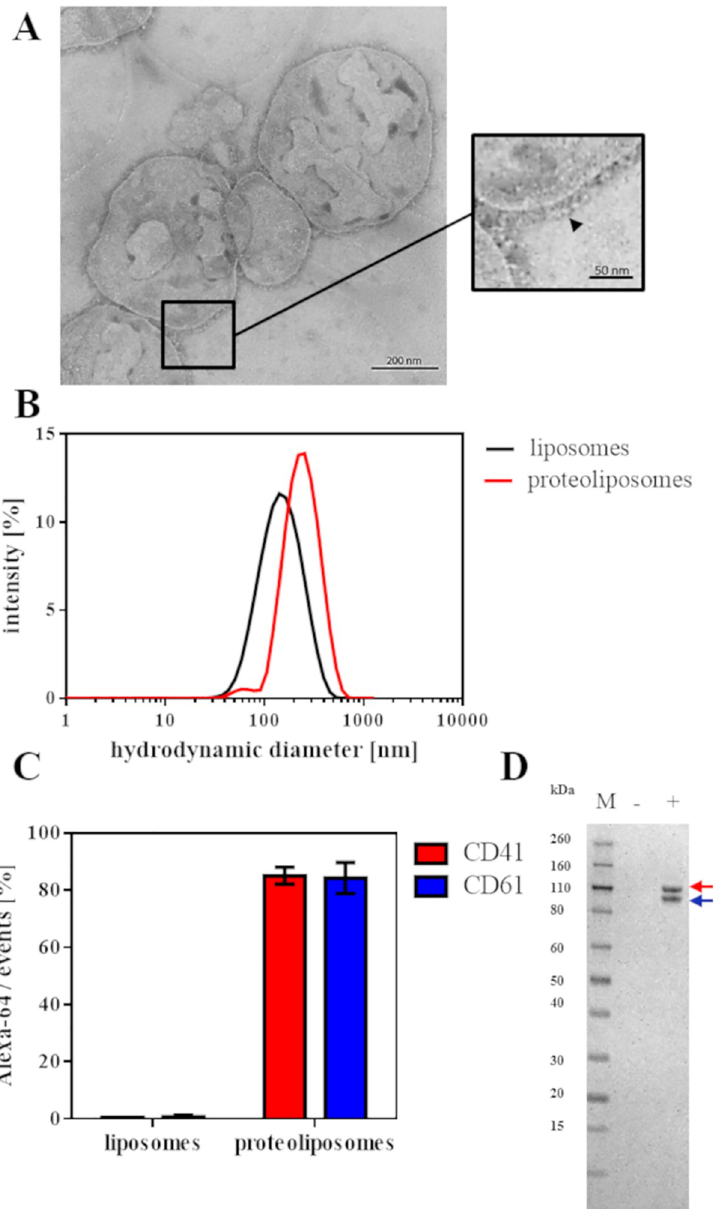
Fig 2. Validation of α IIb β 3 reconstitution into liposomes. A) TEM images of proteoliposomes. The inset shows a close-up view of α IIb β 3 (indicated by arrow) incorporated in a membrane environment. B) DLS data showing the hydrodynamic diameter of liposomes (black) and proteoliposomes (red) of three independent experiments measured in liposome buffer at 37˚C. C) Statistical analysis of FACS-plots with liposomes and proteoliposomes from three independent measurements. Percentages of the mean ± standard error of the mean (SEM) of anti-CD41 (red) and anti-CD61 binding (blue) on PE CF- liposomes were plotted. D) Reductive SDS-PAGE of liposomes (-) and proteoliposomes (+), protein molecular weight standard (M) is shown on the left. The bands corresponding to the α IIb- (red) and β 3-subunit (blue) are indicated by arrows. incubation with Mn 2+ (red) compared to EDTA-treated proteoliposomes (blue). However, also without any additives, binding of PAC-1 to proteoliposomes was increased. By contrast, the flow cytometry measurements with PE CF- proteoliposomes, standard buffer conditions